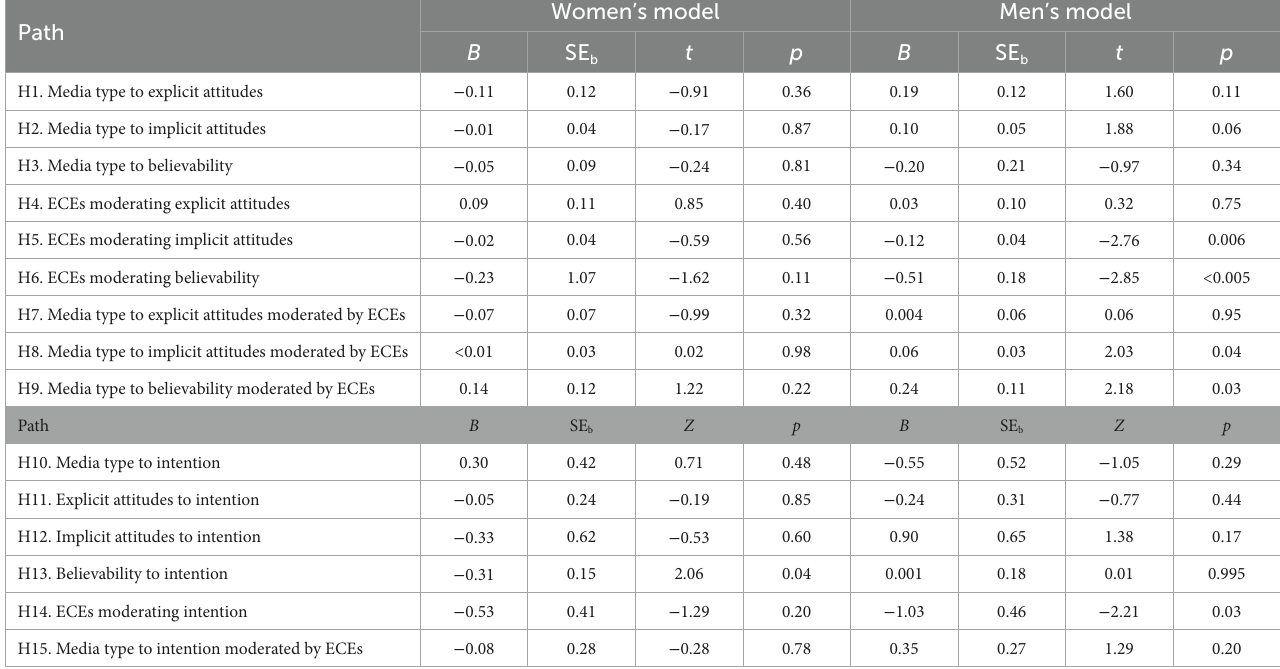
TABLE 5 Study two results with ECEs as moderator; women’s and men’s models.